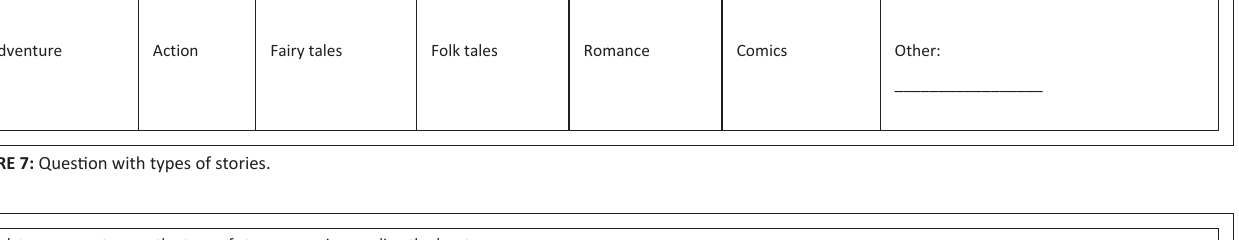
Stick a heart sticker on the type of story you enjoy reading the most and two green stars on the type of story you enjoy reading the least.